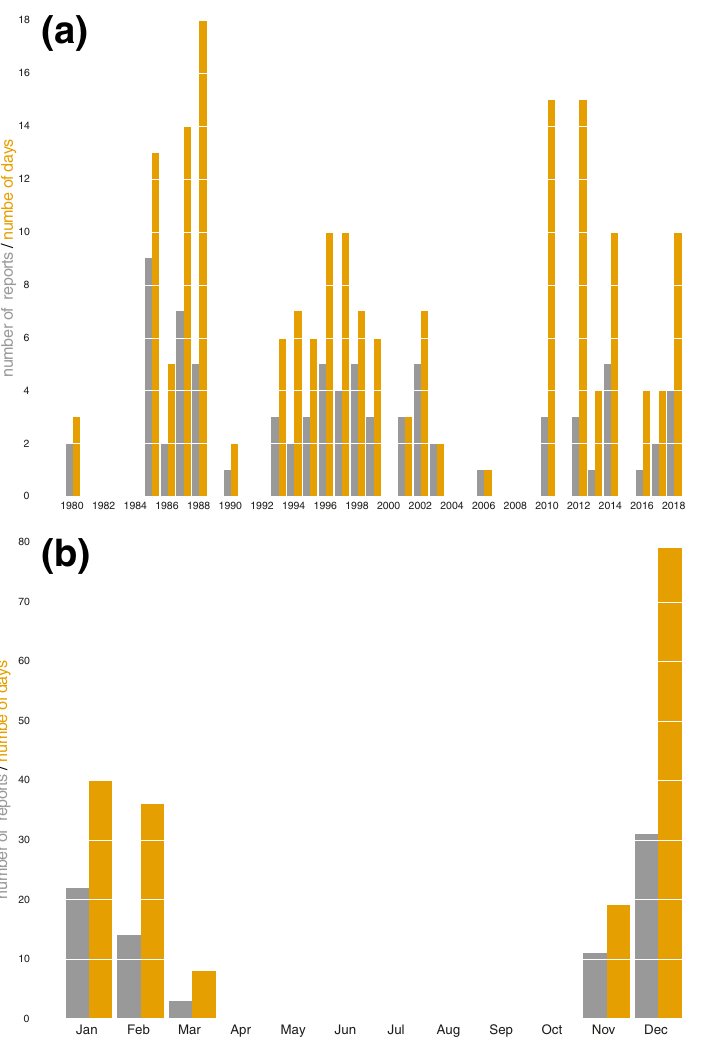
Figure 6. ( a ) The annual distribution of the number of freezing rain reports (orange bars) and the number of freezing rain days (i.e., days with a least one reports of freezing rain, grey bars) and ( b ) the monthly distribution of the number of freezing rain reports and the number of freezing rain days between 1980–2018 based on SYNOP observation from B˘aneasa